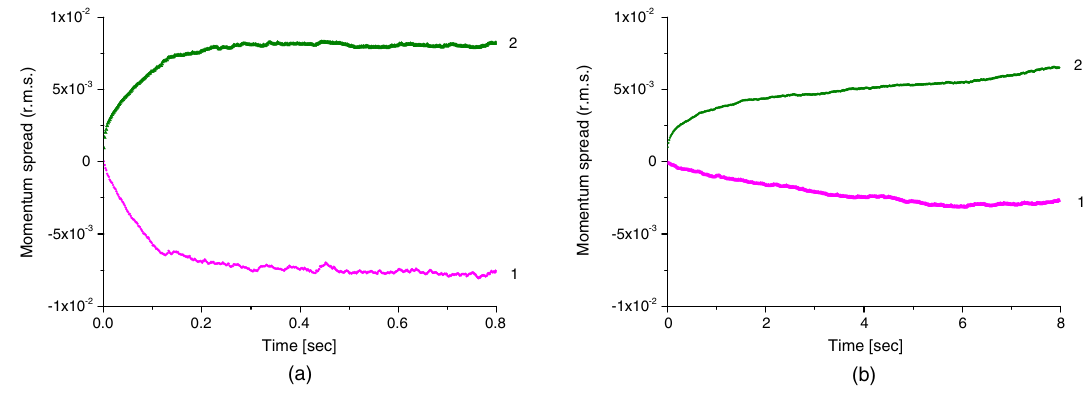
FIG. 11. Mean energy loss (pink curve 1) and energy straggling (green curve 2) of a high-intensity ( N o ¼ 10 7 ions) antiproton beam ¼ 5 (cid:6) 10 þ 11 cm (cid:3) 3 density: (a) ion kinetic energy 3 keV, energy shift (cid:1) T=T ¼ (cid:3) 8 (cid:6) 10 (cid:3) 3 ; interacting with a He target of n tgt (b) kinetic energy 30 keV, energy shift (cid:1) T=T ¼ (cid:3) 3 (cid:6) 10 (cid:3) 3 .